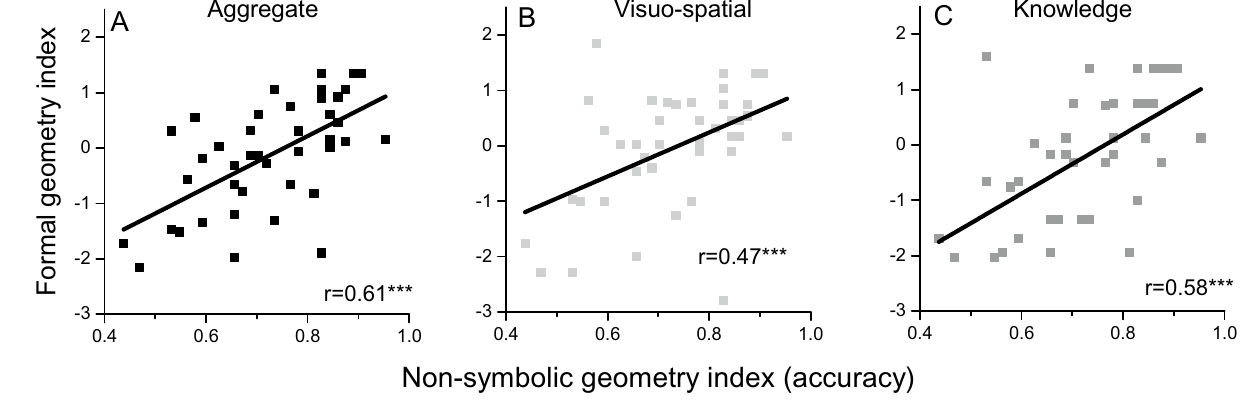
Figure 3. The link between formal and non-symbolic geometry. ( A ) Formal geometry index (z-scores) plotted against z-scores for the non-symbolic, psychophysical geometry test. ( B ) Same as ( A ), but considering only visuo-spatial items in the formal geometry test. ( C ) Same as ( A ), considering only verbal knowledge items. Lines are best linear fits. ***p <= 0.001.